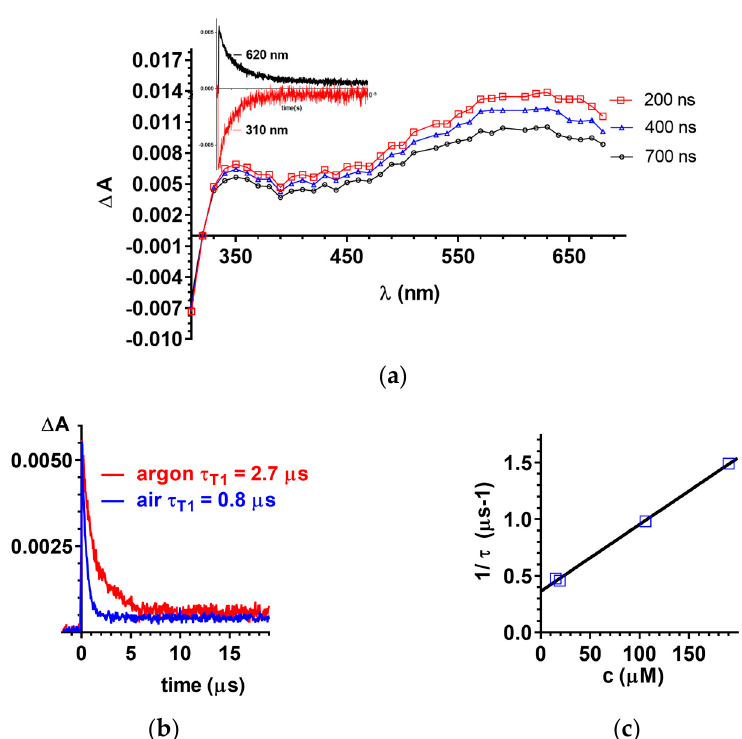
Figure 5. ( a ) Transient absorption spectrum of 8-TG (0.62 mM) in argon-saturated aqueous solution at various delay times ( λ exc = 266 nm, 3 mJ). Insert: kinetic traces of the 620 nm absorbance decay and 310 nm the ground state depopulation of 8-TG in argon-saturated aqueous solution; ( b ) Kinetic traces and Stern–Volmer plot of reciprocal of triplet lifetime vs. concentration of 8-TG in argon-saturated solution.